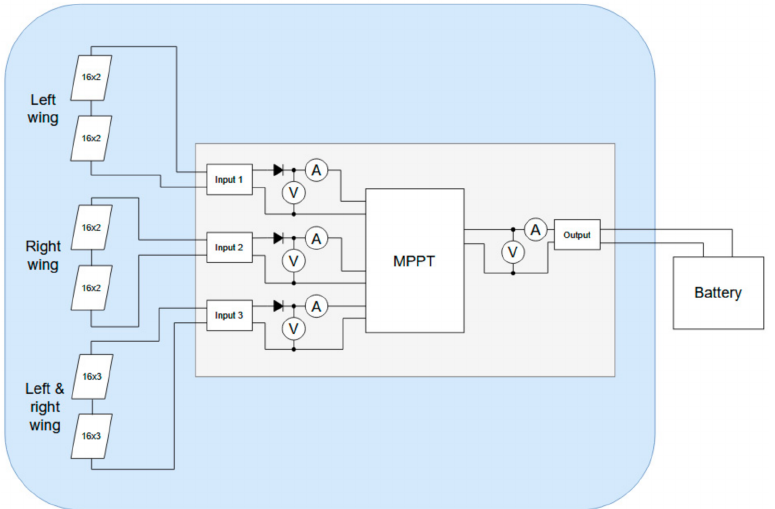
Figure 10. Endurance extension system (blue colored shape). The same battery used to power the UAV is used also in connection with the endurance extension